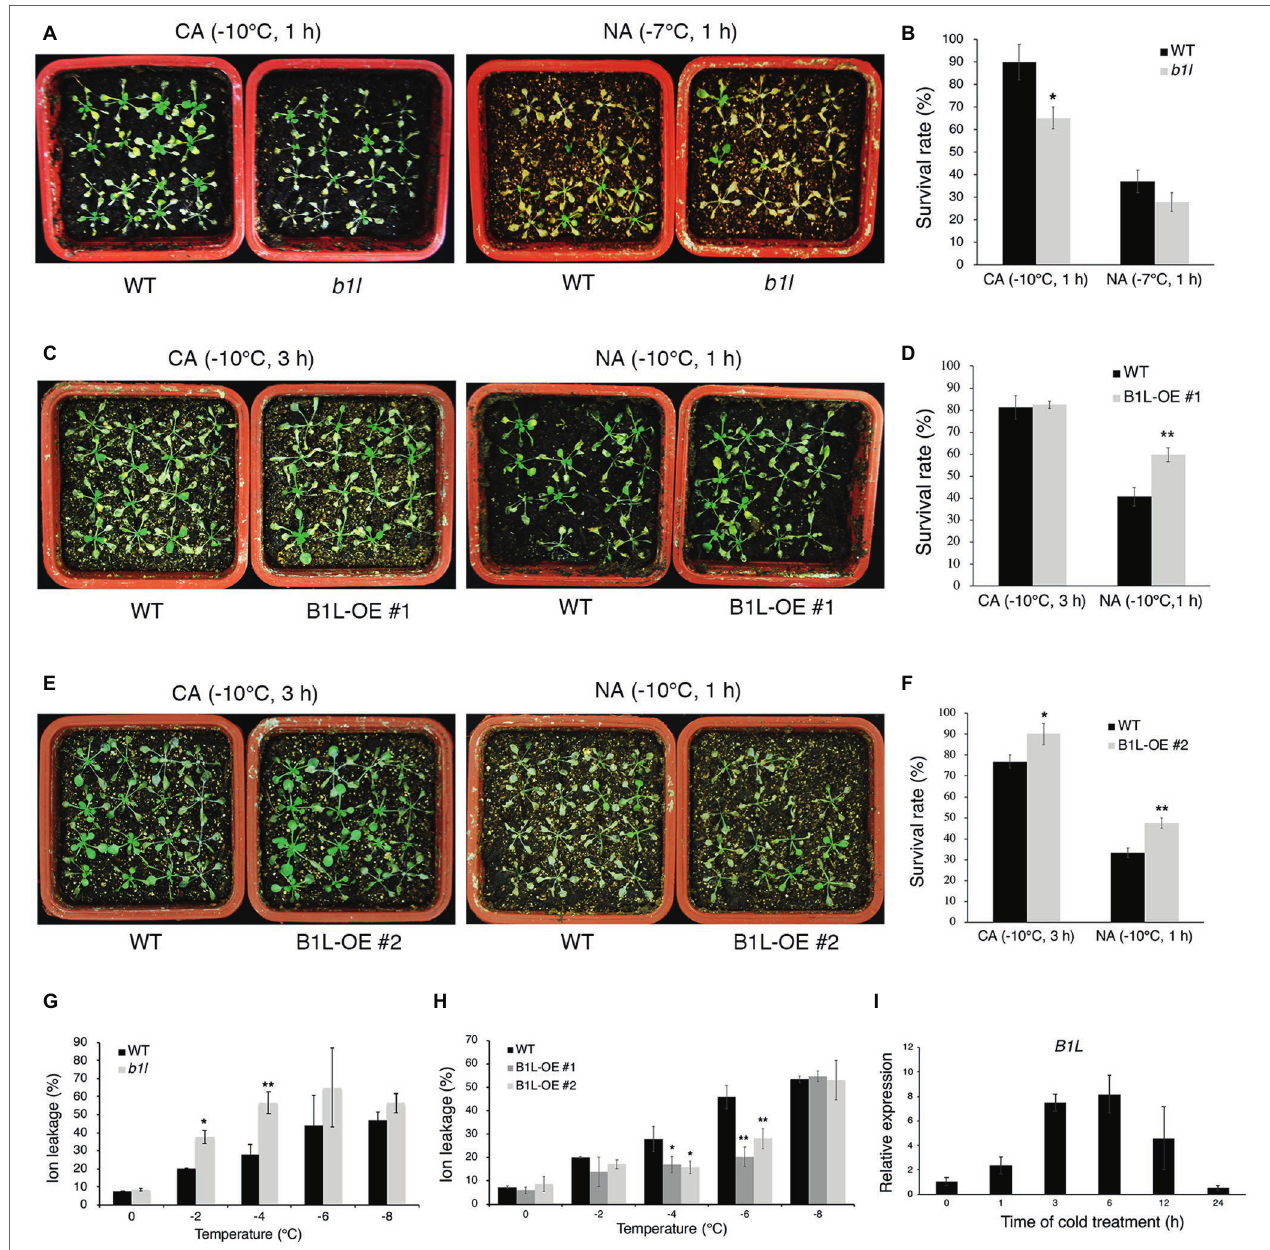
FIGURE 1 | B1L positively modulates freezing tolerance in Arabidopsis . (A–F) Freezing tolerance (A,C,E) and survival rates (B,D,F) of wild type (WT) , b1l mutant, and B1L - overexpressing plants under non-acclimated (NA) or cold-acclimated (CA) conditions. The 3-week-old plants were treated at −7 or −10°C for 1 h (NA) or were pretreated at 4°C for 3 days and then treated at −10°C for 1 or 3 h (CA). For each line, the survival rate assay was performed with four pots of 16 plants and scored 5 days later. The photos presented one pot of each line. The data are shown as means of three independent biological replicates ± SD. Asterisks indicate significant differences (* p < 0.05, and ** p < 0.01) from wild type. (G,H) Ion leakage of wild type, b1l mutant, and B1L-overexpressing plants in (A,C,E) after exposure to the temperature indicated. Data are means ±SD. n = 4 leaves, each from a different plant. Asterisks indicate significant differences (* p < 0.05 and ** p < 0.01) from wild type. (I) Expression of B1L in wild type under cold treatment. Total RNA was extracted from 12-day-old seedlings treated at 4°C for 0, 1, 3, 6, 12, 24 h and then subjected to qRT-PCR. Actin2/8 was used as a control. The expression of B1L in untreated wild type was set to 1. The data are shown as means of three independent biological replicates ±